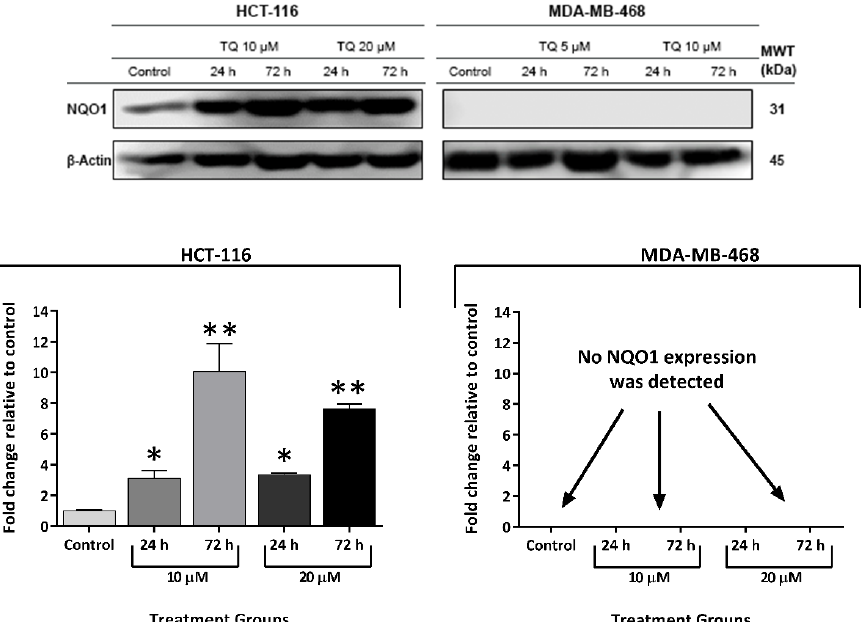
Figure 8. Representative western blot bands and mean ± SD bars showing NQO1 expression in HCT-116 and MDA-MB-468 protein lysates after TQ treatments (24 and 72 h) using 10, 20 µM and 5, 10 µM TQ, respectively. Antibodies to NQO1 and housekeeping gene β-Actin were used. A time-dependent increase in NQO1 was observed in HCT-116, while no NQO1 expression was seen in MDA-MB-468 lysates. Assays were repeated three times. Asterisks indicate a statistically significant (* p ≤ 0.05, ** p ≤ 0.01) change compared to the